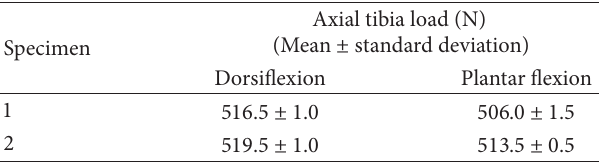
Table 1: Average axial tibia loading